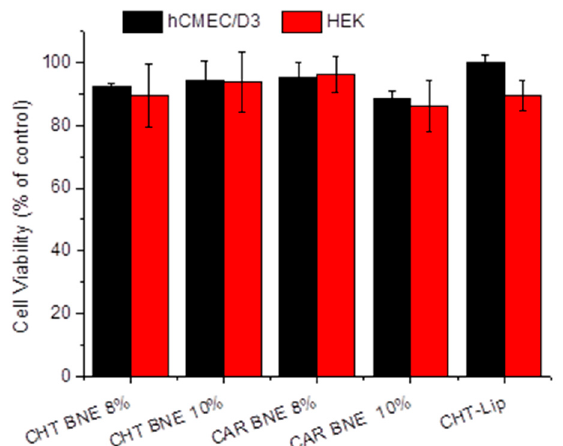
Figure 6. Cell viability of the hCMEC/D3 and HEK-294 cells following the 48 h incubation of various BNN27 nanoformulation types at a BNN27 concentration of 1 µM.